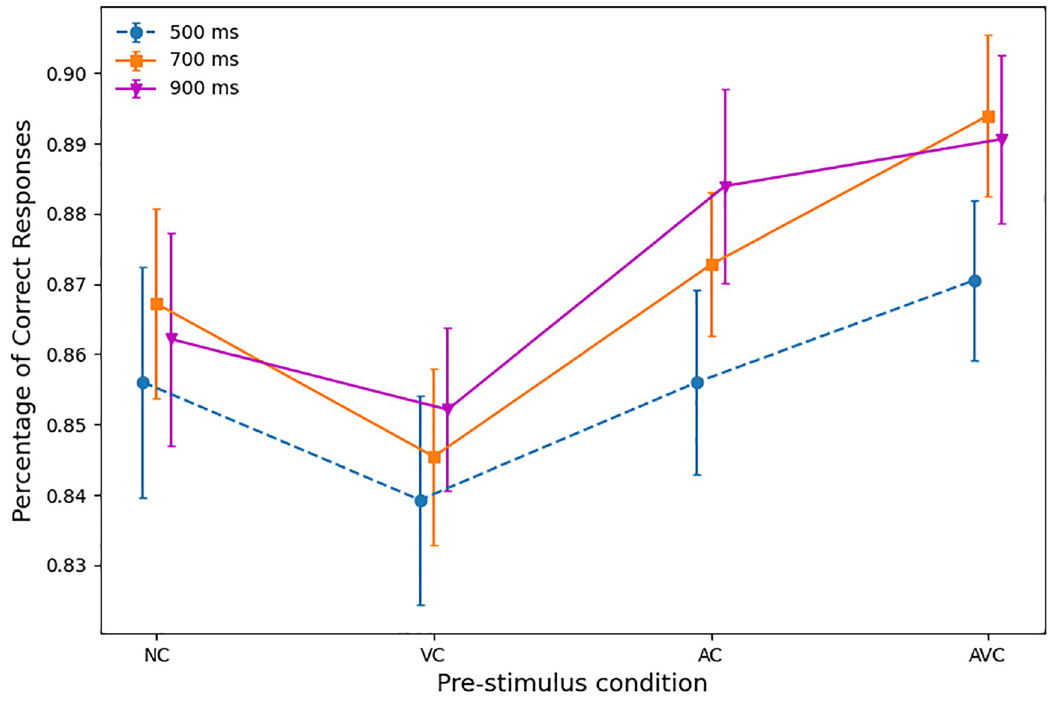
Fig 3. Mean accuracy (percentages) with standard error according to SOA (500, 700 and 900 ms) and pre-stimulus (NC, VC, AC and AVC).